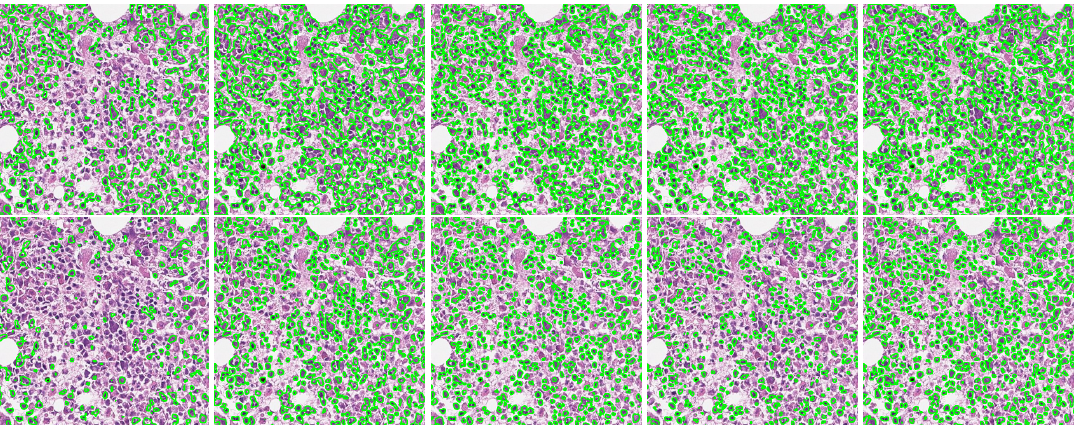
Figure 4. Visual segmentation results of the CNN-based methods trained using MIC17 and BNS datasets over an image used in the HistoDSSP